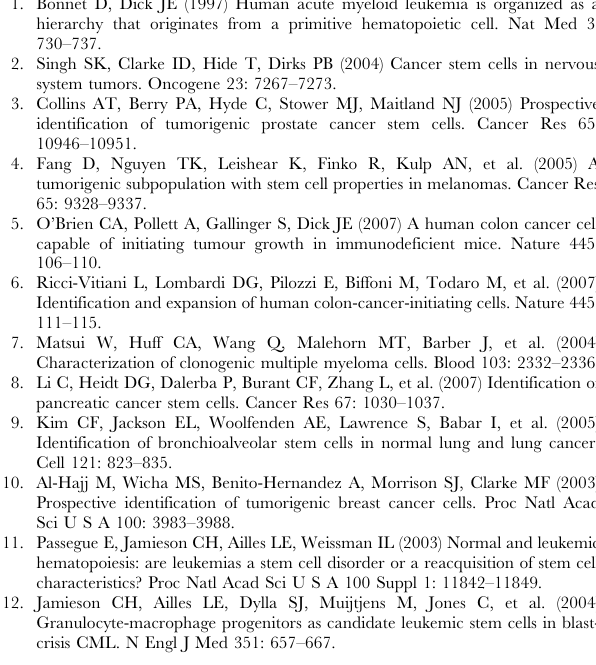
Figure S3 PROCR + /ESA + MDA-MB-231 cells asymmetrically divide in vivo . A. PROCR + /ESA + MDA-MB-231 cells with 93.8 percent purity were collected for in vivo inoculation in NOD/SCID mice. B. The marker profile of the cells derived from the tumor